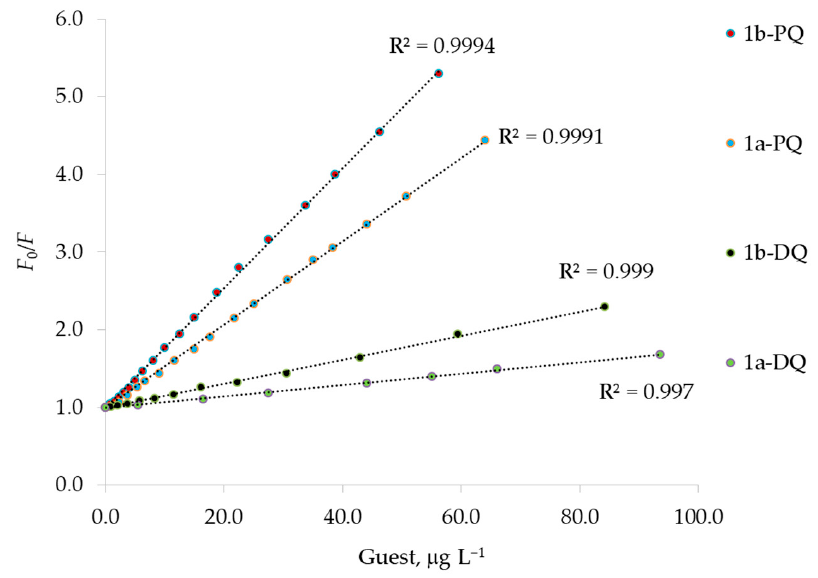
Figure 9. Stern–Volmer plots for the fluorescence quenching of 1a and 1b host with paraquat, PQ, and diquat, DQ, as guests. The excitation wavelength was set to 285 nm and 263 nm, and the fluorescence value F was measured at 336 nm and 416 nm for the fluorophores 1a and 1b, respectively. F 0 is the fluorescence intensity in the absence of quencher PQ or DQ at 336 nm or 416 nm. Table 6. Association constants of H ‐ G complexes at 25 °C, reported as log K . Paraquat, PQ, and di ‐ quat, DQ, are the guests, G, and the compounds 1a and 1b are the fluorescent hosts, H. The values were determined by Equation (3). Uncertainties are given as standard deviation.